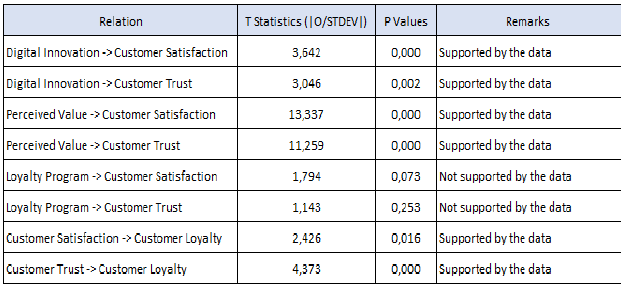
Table 3: Structural Model Measurement (SEM)